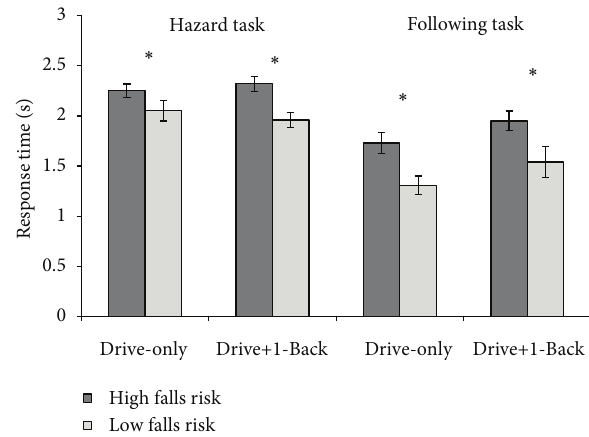
Figure 2: Brake response times. Mean brake response time in seconds for the high and low falls risk driver groups in drive-only and drive + 1-Back task conditions in the hazard response and car following paradigms. Error bars represent one standard error of the mean. ∗ 𝑃 < .05